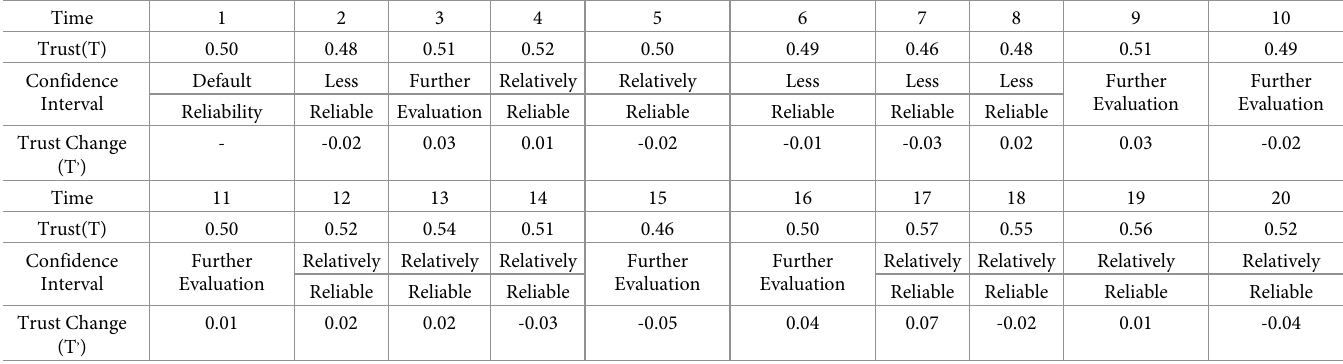
Table 7. Default trust values in Fig